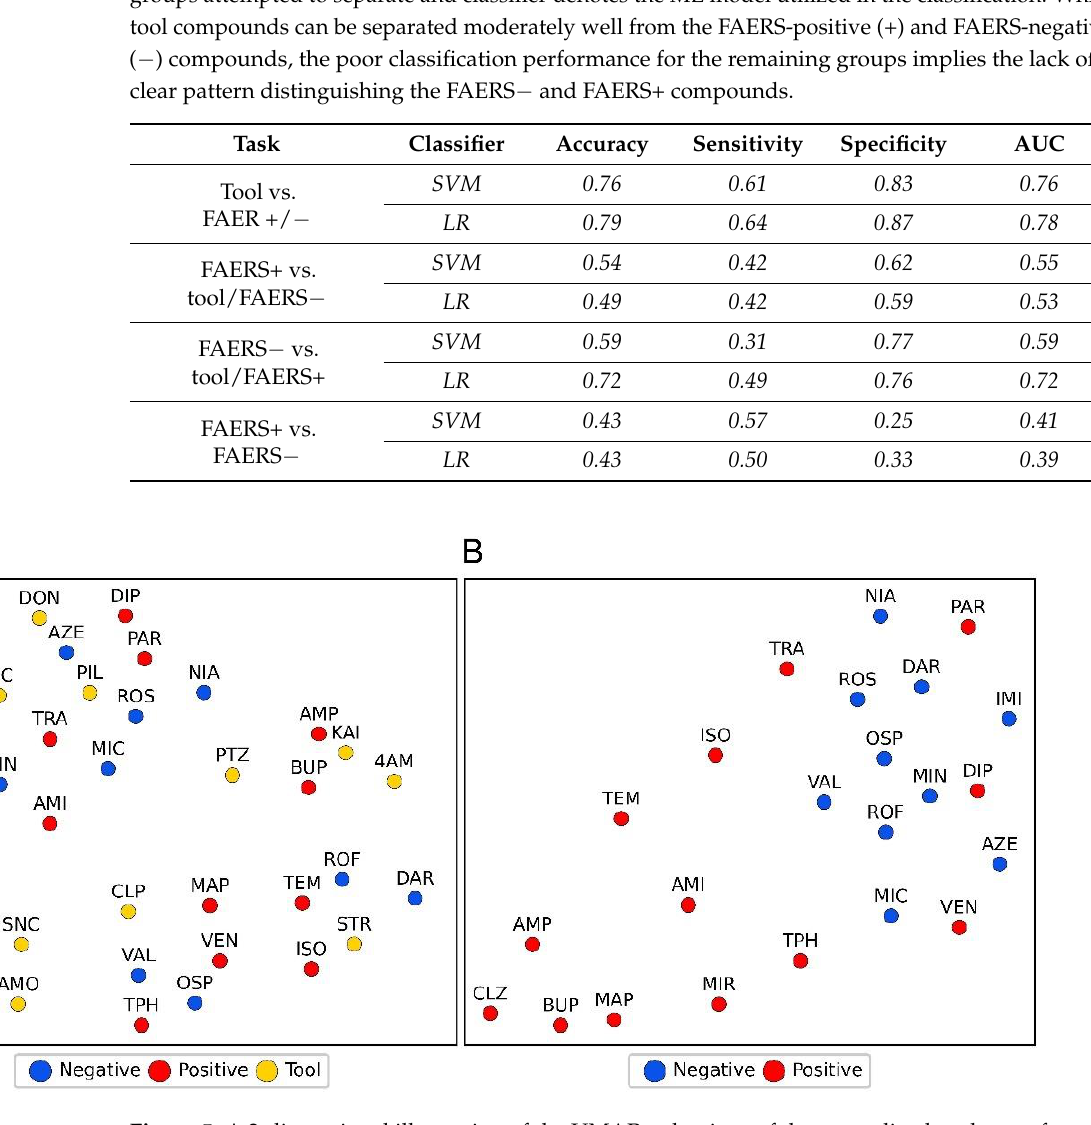
Figure 5. A 2-dimensional illustration of the UMAP reductions of the normalized rank-transformed replicate means of RNA-seq normalized read counts. ( A ) No clustering by compound category (tool, FAERS-positive, FAERS-negative compounds) is apparent. ( B ) A similar reduction for the vectors of a number of differentially expressed genes by FAERS-positive and FAERS-negative with a positive fold-change shared with each tool compound. Abbreviations: The 11 tool compounds: 4-aminopyridine (4AM), amoxapine (AMO), bicuculine (BIC), chlorpromazine (CPL), donepezil (DON), kainic acid (KAI), picrotoxin (PIC), pilocarpine (PIL), pentylenetetrazol (PTZ), strychnine (STR), and SNC80 (SNC). The 13 FAERS-positive compounds: amitriptyline (AMI), aminophylline (AMP), bupropion (BUP), clozapine (CLZ), diphenhydramine (DIP), isoniazid (ISO), maprotiline (MAP), mirtazapine (MIR), paroxetine (PAR), temozolomide (TEM), theophylline (TPH), tramadol (TRA), and venlafaxine (VEN). The 10 FAERS-negative compounds: azelastine (AZE), darifenacin (DAR), imiquimod (IMI), miconazole (MIC), minoxidil (MIN), niacin (NIA), ospemifene (OSP), rosiglitazone (ROS), roflumilast (ROF), and valdecoxib (VAL).